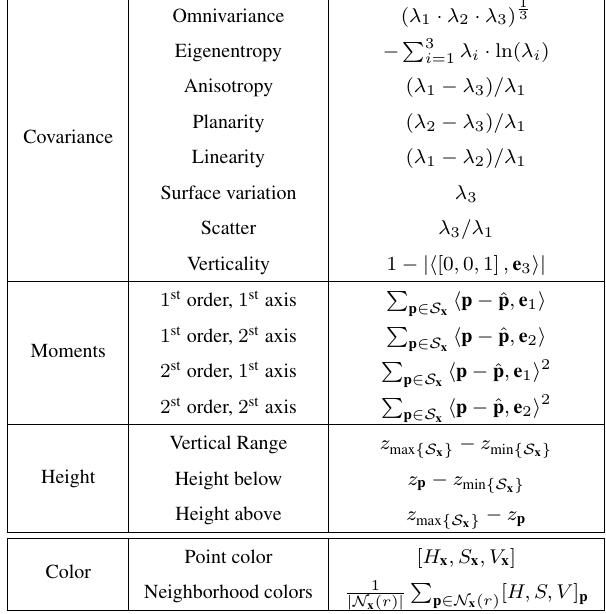
Table 1. Our set of geometric (top) and color features (bottom) computed for points in local neighborhood S x